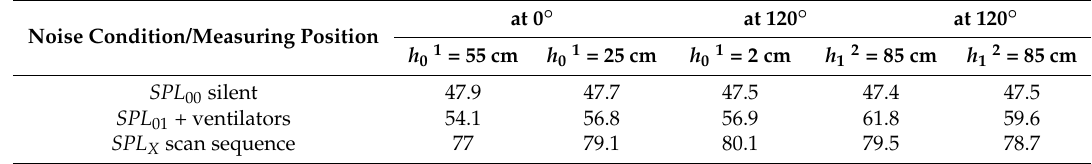
Figure 4. Arrangement of measurement of the acoustic noise SPL distribution in the vicinity of the TMR96 scanning tube; ( a ) SPL meter situated at the distance D L = 45 cm from the scanning area center (point PC), in the height h = 120 cm above the floor level; ( b ) directional pattern for SE/GE sequences together with SPL 01 values. Table 1. Measured SPL [dB(C)] at different positions.